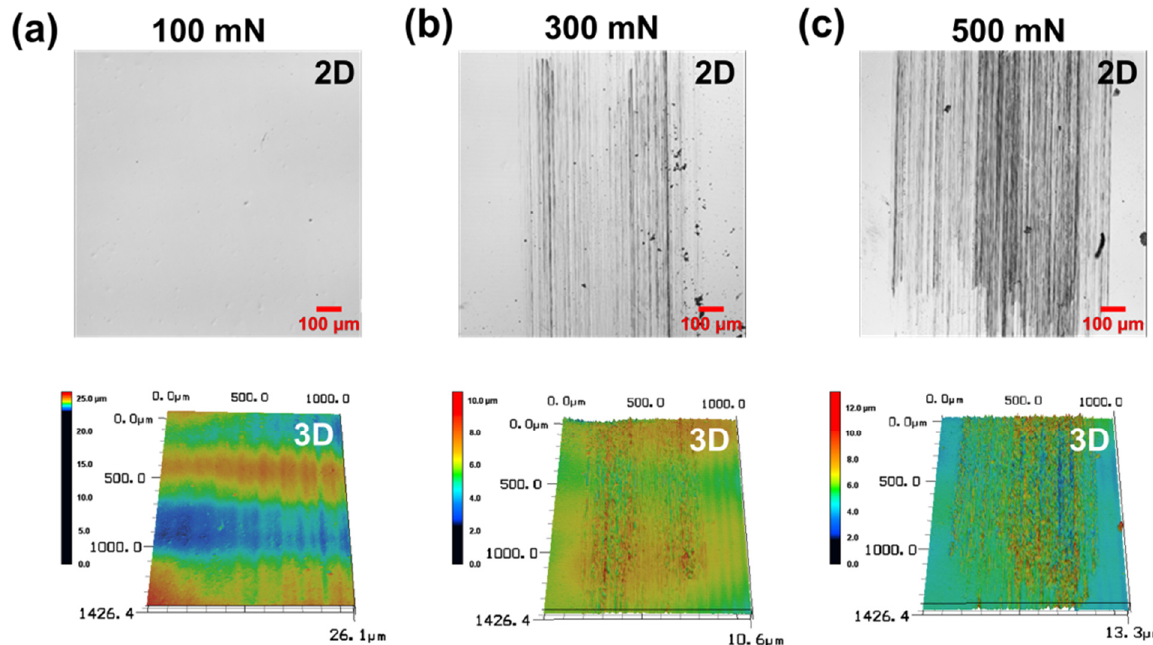
Figure 6. Confocal microscope 2D/3D profile images of wear track of PDMS specimen under ( a ) 100 mN, ( b ) 300 mN, ( c ) 500 mN normal loads and 1 wt % surfactant–water lubricated condition after 10,000 cycles.